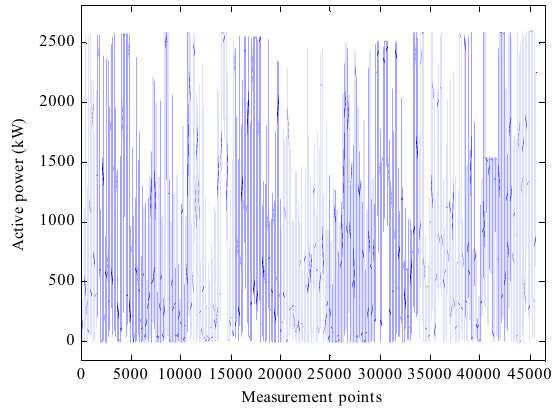
Figure 1. Active power of the turbine after removal of gaps.